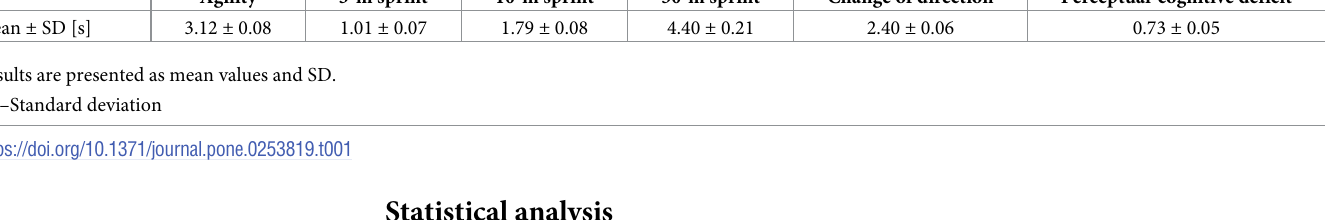
The data were analyzed using SPSS statistical software version 25.0 (SPSS, Inc., Chicago, IL). Mean values and standard deviations (SD) were calculated for each variable. Regarding the reliability of the tests (see Procedures ), ICC values (absolute agreement, single measures) and CV values ((SD of all trials / mean of all trials) � 100) were computed. Relationships between agility performance with linear-sprint (5 m, 10 m, and 30 m), change-of-direction performance, and the perceptual-cognitive deficit were determined by Pearson’s product-moment correlations (r) with 95% confidence intervals (95% CI), as normal distribution of the data was given. The magnitude of the correlation coefficient was considered as small (0.1 � r < 0.3), moderate (0.3 � r < 0.5), large (0.5 � r < 0.7), very large was set to 0.05.